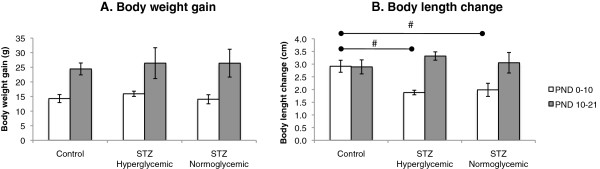
Body weight gain and length growth between PND 0 to 21. Body weight gain (g) (A) and body length growth (cm) of Control (n = 10), STZ hyperglycemic (n = 6), and STZ normoglycemic (n = 6) rats. (B) Values expressed as mean ± standard error of mean. (A) and (B). Significant time effect, p < .001. (B) # trend toward significance of a time and group interaction effect, p = 0.064 (ANOVA followed by Tukey’s test).